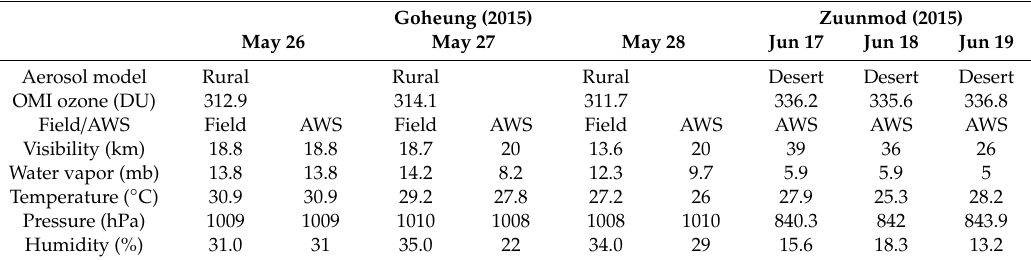
Table 3. Atmospheric input parameters employed for absolute